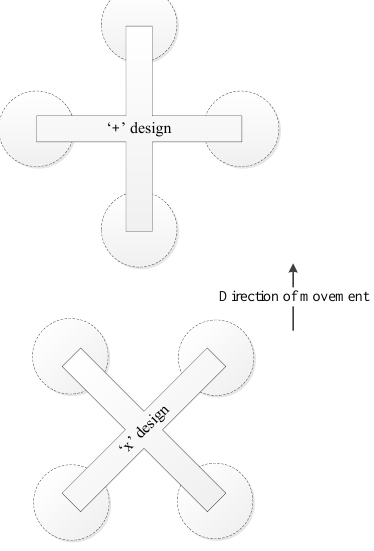
Figure 5. Quadcopter “+” and “x” designs for the same direction of